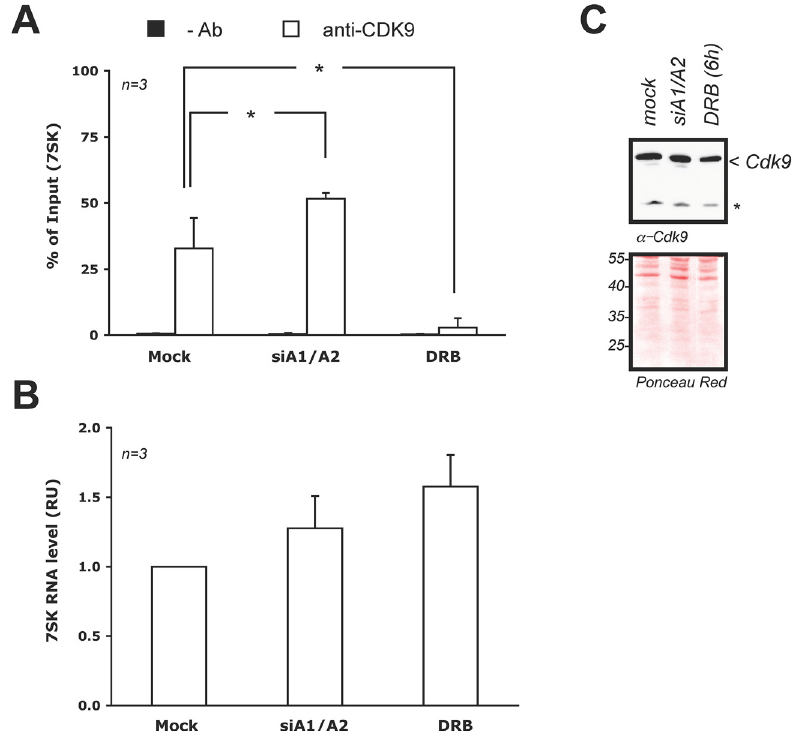
Fig 4. Linking hnRNP A1/A2 with P-TEFb. A , Association of 7SK with P-TEFb. The association between 7SK snRNA and CDK9 was tested 72 hours post-transfection with the A1/A2 siRNAs, or 6 hours after treatment with DRB (100 μ M). RNA immunoprecipitation (RNA-IP) with anti-CDK9 or without antibody as control were performed and the recovered RNA was quantitated by qRT-PCR with primers specific for 7SK. Data are presented as percent of input 7SK and are averages of 3 experiments with error bars representing SD. * : p < 0.05, two tailed, two sample equal variance, Student ’ s t-test. B , Relative amount of 7SK RNA in extracts used for RNA-IP experiments quantified by qRT-PCR. The amounts were normalized for ACTB , B2M and mock treatment. C , The level of CDK9 in input samples was evaluated by immunublotting using an anti-CDK9 antibody and Ponceau staining of the membrane to show equivalent loading. The presence of a non-specific band reacting with the anti-CDK9 antibody is indicated by an asterisk ( *